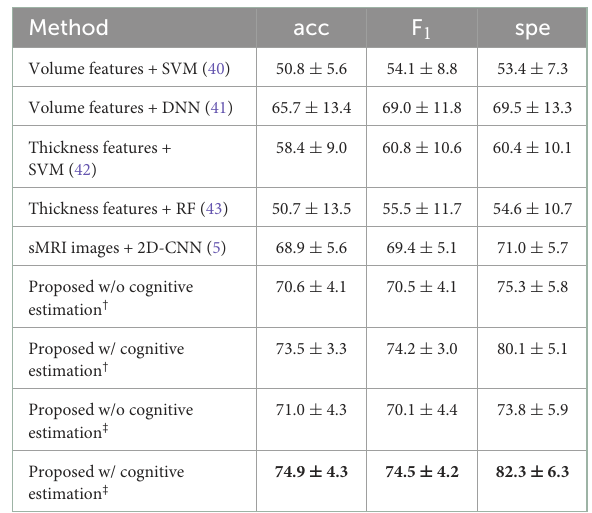
TABLE 2 Comparison on sMRI-based studies for EP classification.